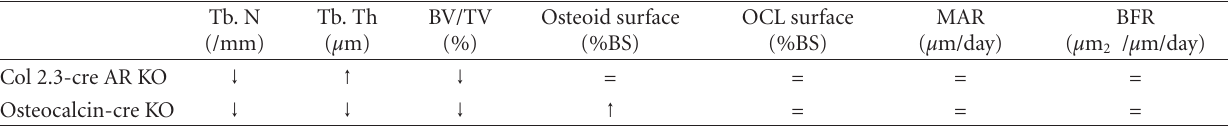
Table 5: Overview bone parameters in osteoblast-specific AR knockout